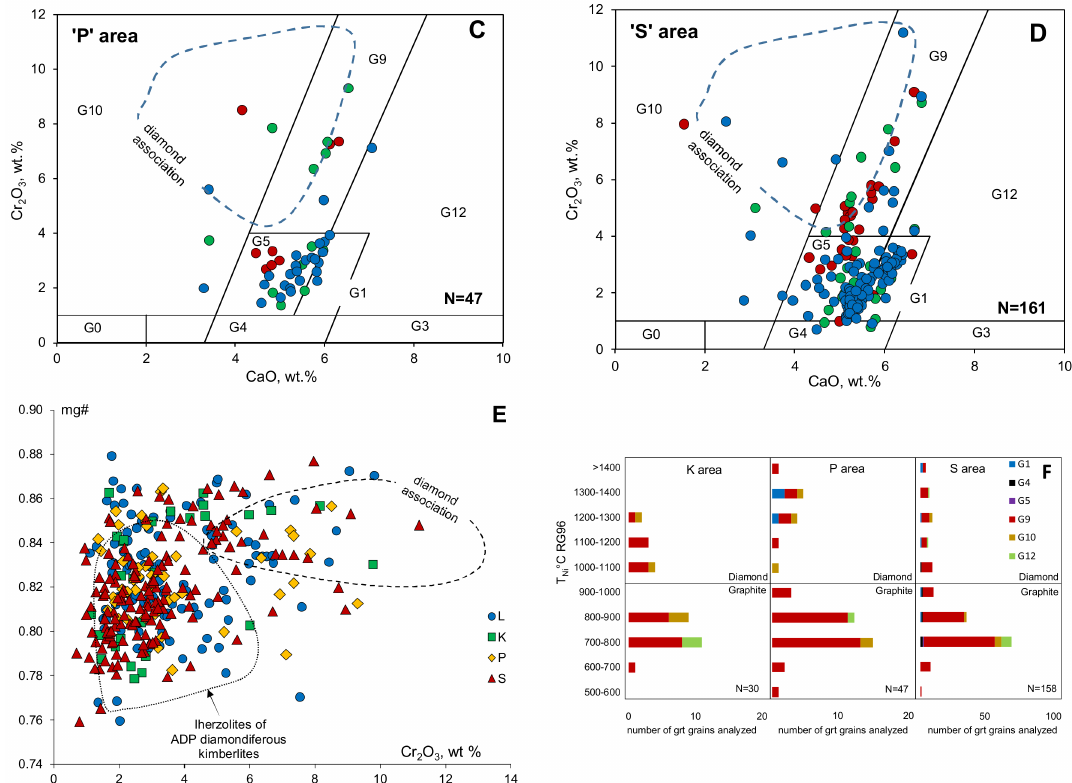
Figure 4. Chemical composition of pyrope. ( A – D ) CaO–Cr 2 O 3 diagram [27]. Diamond association, high-chromium G9 and G10 pyrope [28–30]; N, number of grains analyzed. ( E ) Mg# vs. Cr 2 O 3 , lherzolites of the ADP diamondiferous kimberlites [11,30,35,37,38,43]. ( F ) Distribution of T Ni [32] for the pyrope of ‘K’, ‘P’, and ‘S’ areas. Graphite–diamond transition drawn based on the Cpx-derived geotherm.